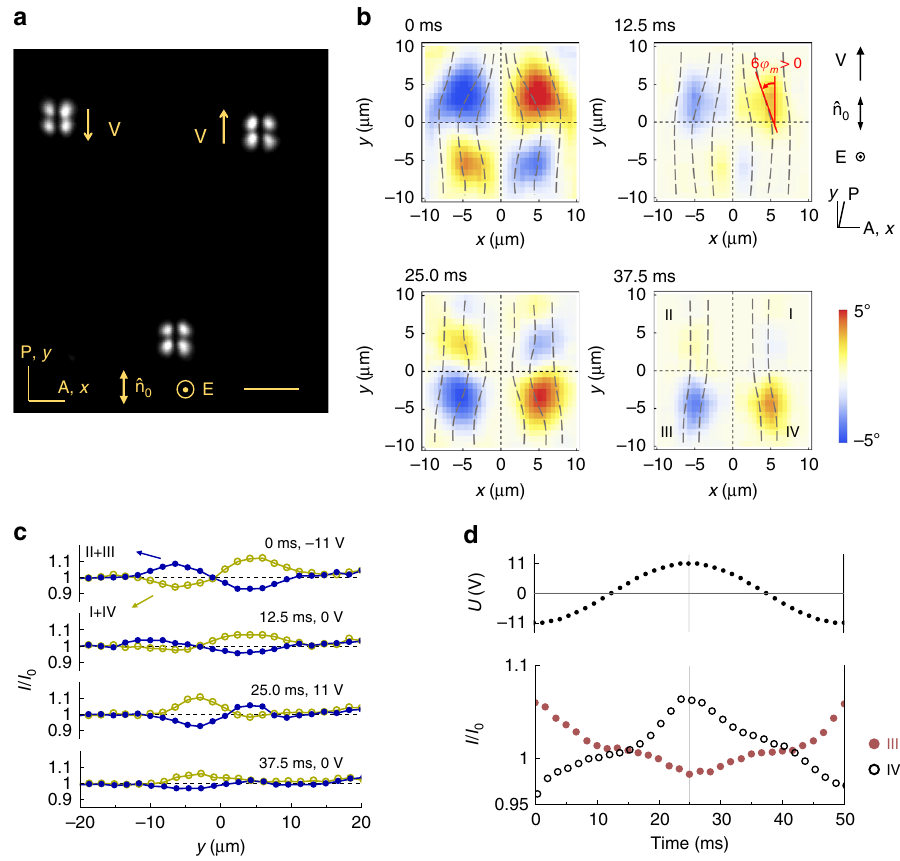
solitons driven by voltage 8.0 V and frequency 20 Hz. a Polarizing microscope texture. Scale bar 30 µ m. b Azimuthal director distortions Fig. 1 B l 0 φ x ; y ; t ð Þ reproduced from polarizing microscopy with two polarizers crossed at 78°. The time step between images is 1/4 of the voltage period, with m “ 0 ms ” corresponding to the negative extremum of the voltage; right (I + IV) and left (II + III) parts of the bullet at different voltages/times. d Time/voltage dependence of light intensity transmitted through quadrants III and IV. In c , d , I is normalized by the transmitted intensity I 0 outside the